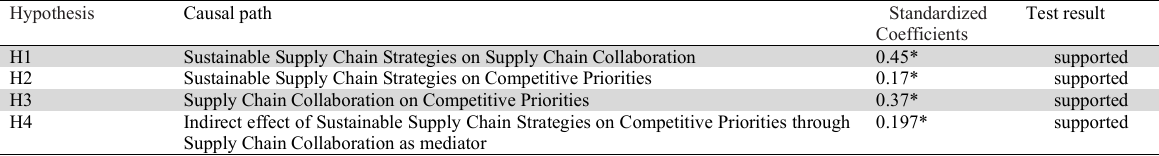
Fig. 2. Result of path